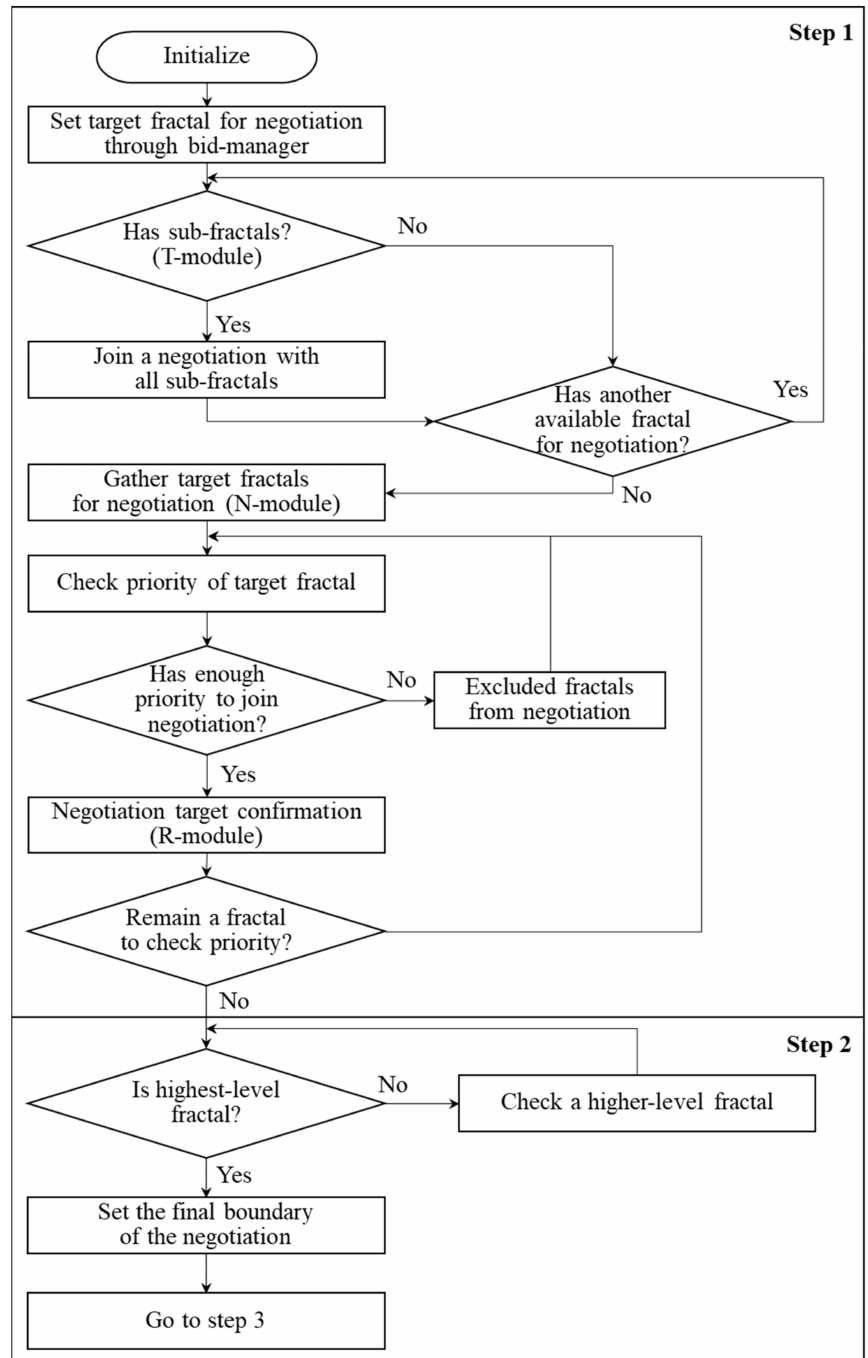
Figure 17. Steps 1 and 2 of hybrid-type